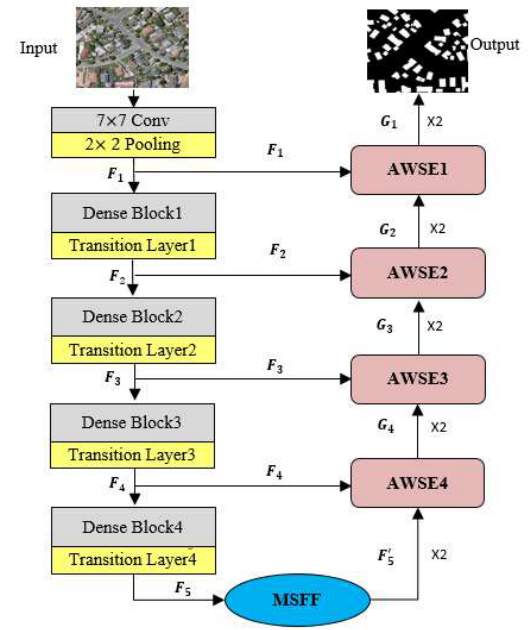
Figure 1. Overview of the proposed model